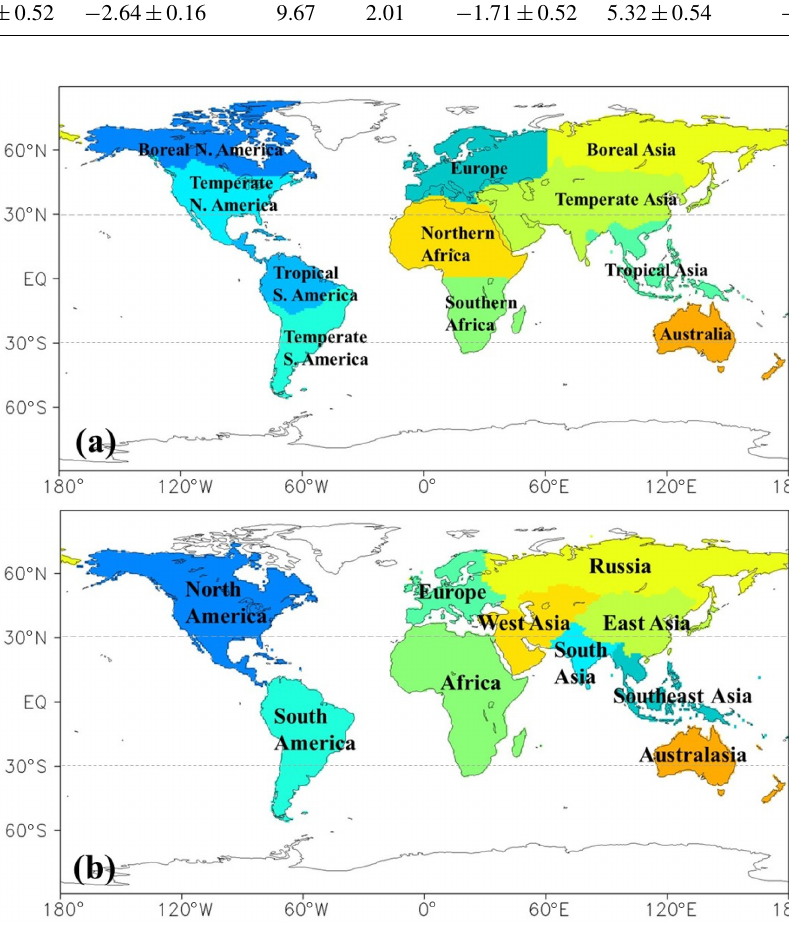
Figure 3. Map of regional masks used in calculating regional fluxes: (a) the TRANSCOM region and (b) the RECCAP2 region.